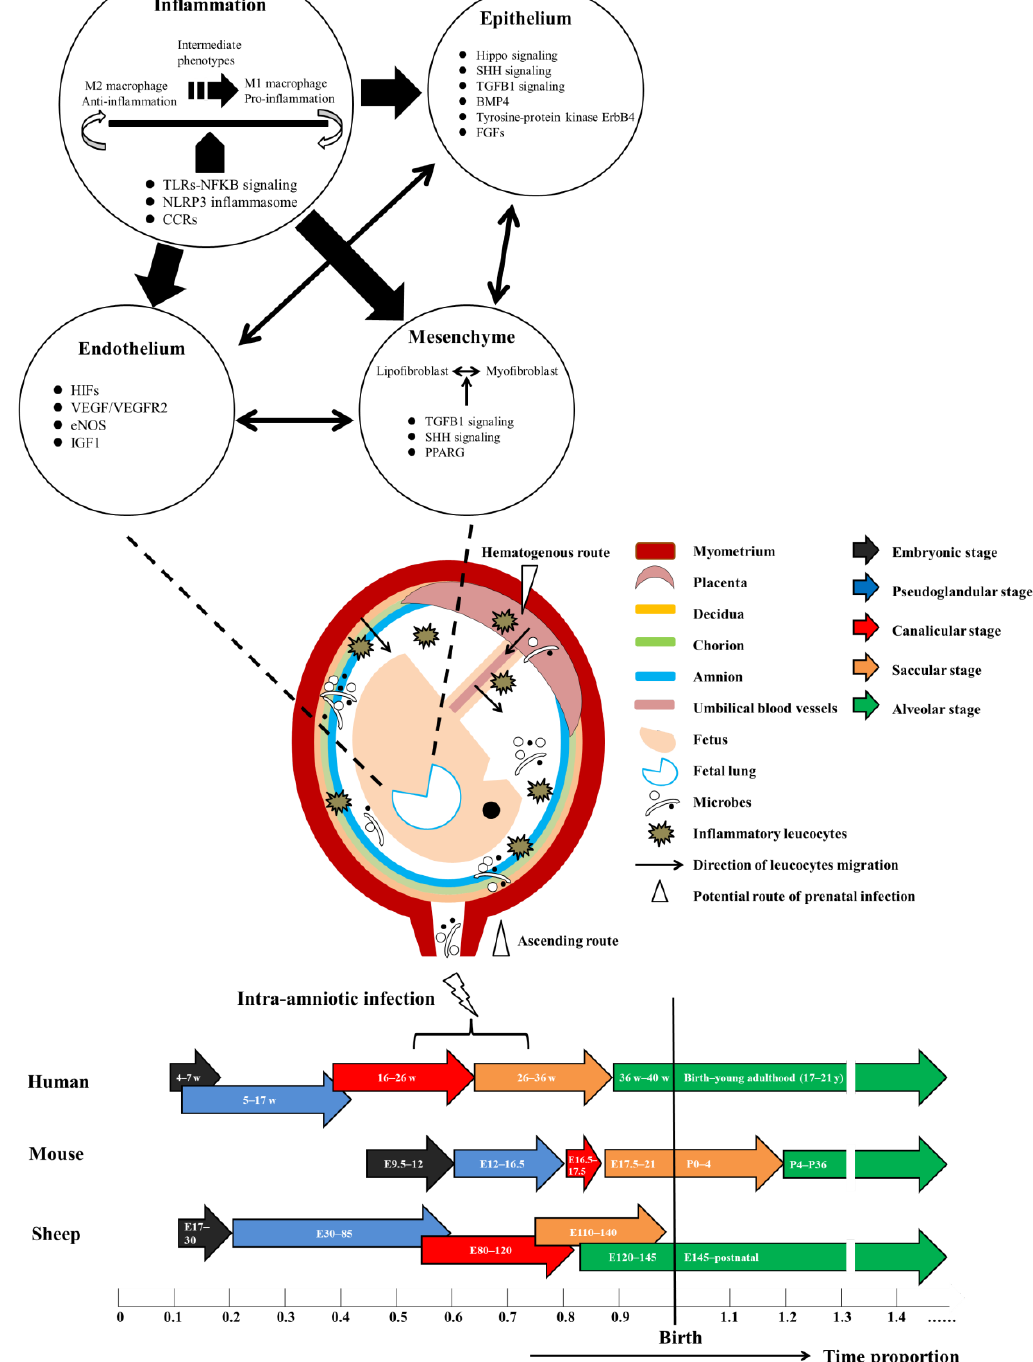
Figure 1. Schematic illustration of prenatal infection between pseudoglandular and canalicu- lar/saccular stage and pulmonary consequences in the three lung compartments. Lung develop- mental stages between humans and animals which are most frequently used in preclinical studies are compared. The listed potential molecular mechanisms are mainly derived from in vivo animal models focusing on prenatal infection. BMP4: bone morphogenetic protein 4, CCRs: C-C motif re- ceptors, eNOS: endothelial nitric oxide synthase, FGFs: fibroblast growth factors, HIFs: hypox- ia-inducible factors, IGF1: insulin-like growth factor 1, NFKB: nuclear factor kappa B, NLRP3: NLR family pyrin domain-containing protein 3, SHH: sonic hedgehog, TGFB1: transforming growth factor beta 1, TLR: toll-like receptor, PPARG: peroxisome proliferator-activated receptor gamma, VEGF: vascular endothelial growth factor.